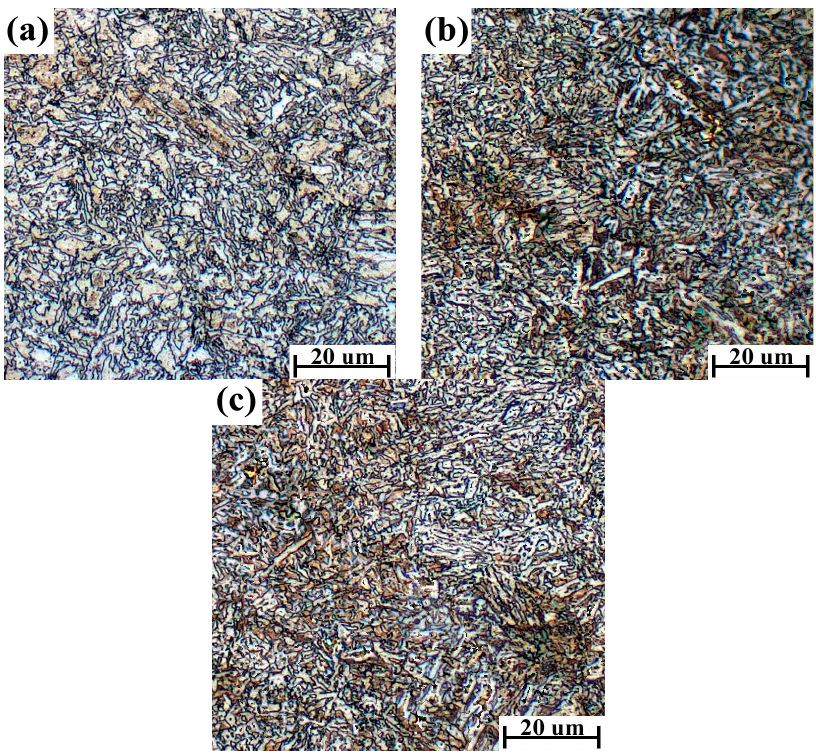
Figure 1. Optical micrographs of steels with different Mo content: ( a ) steel #1, Mo-free; ( b ) steel #2, 0.134 wt. % Mo; ( c ) steel #3, 0.273 wt. % Mo.